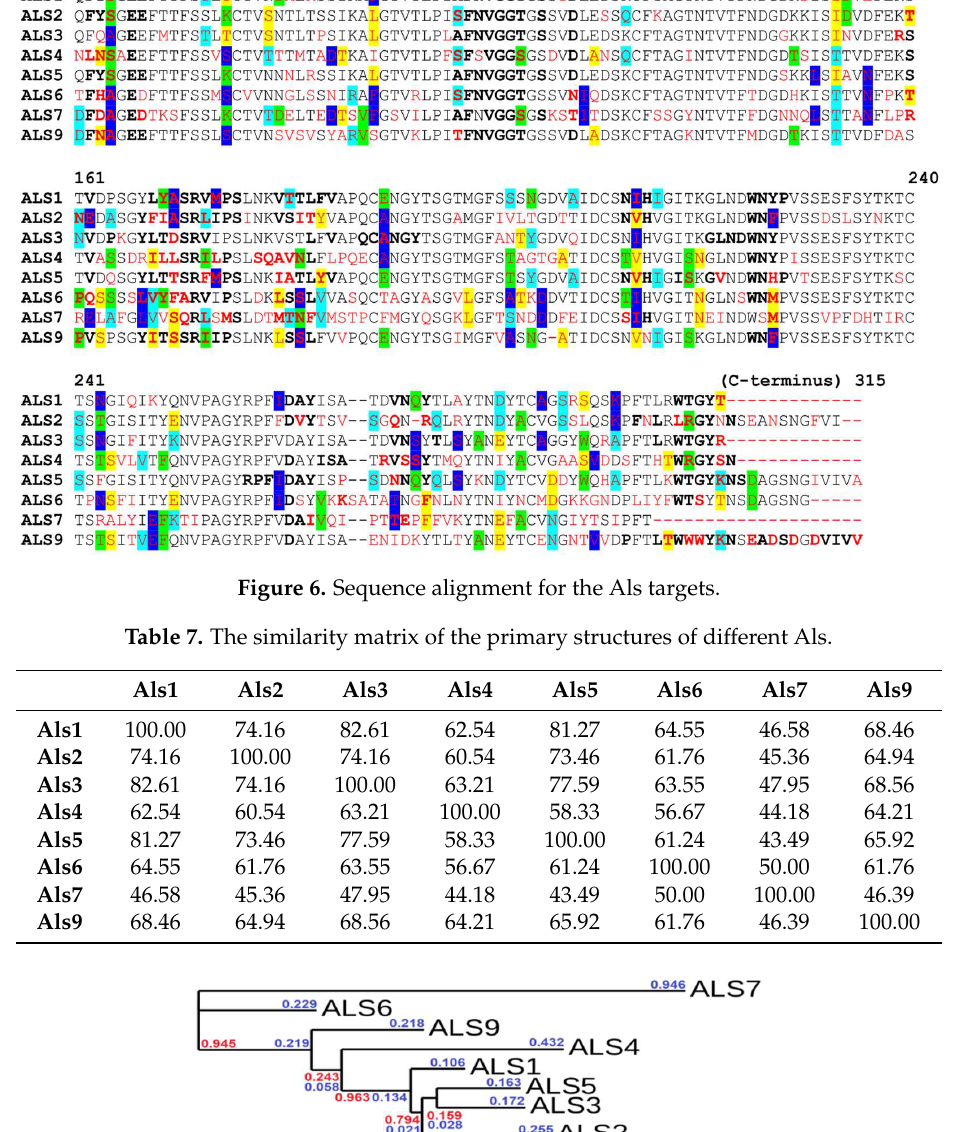
Figure 7. Sequence homology of Als proteins. The branch support values are depicted in red, while the branch length values are depicted in blue.